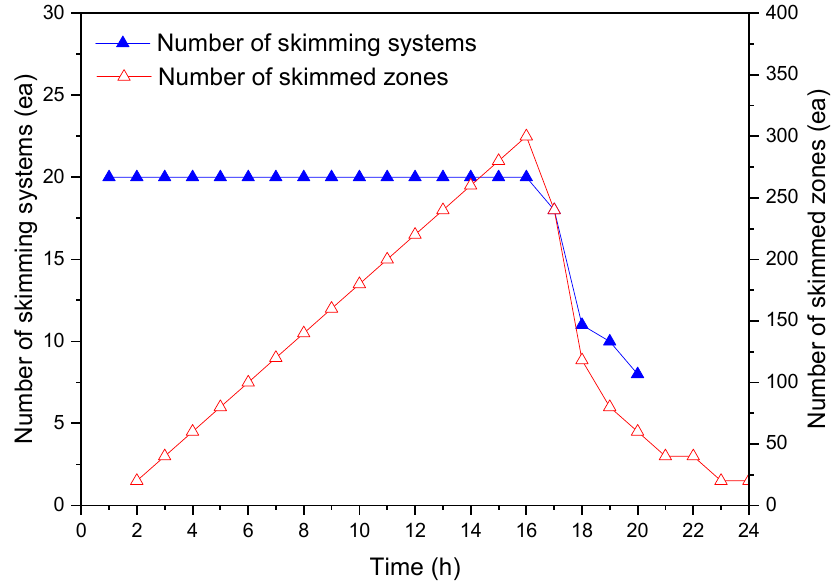
Figure 7. The number of skimming systems used in the calculation and the number of skimmed zones with time in the SNR model.